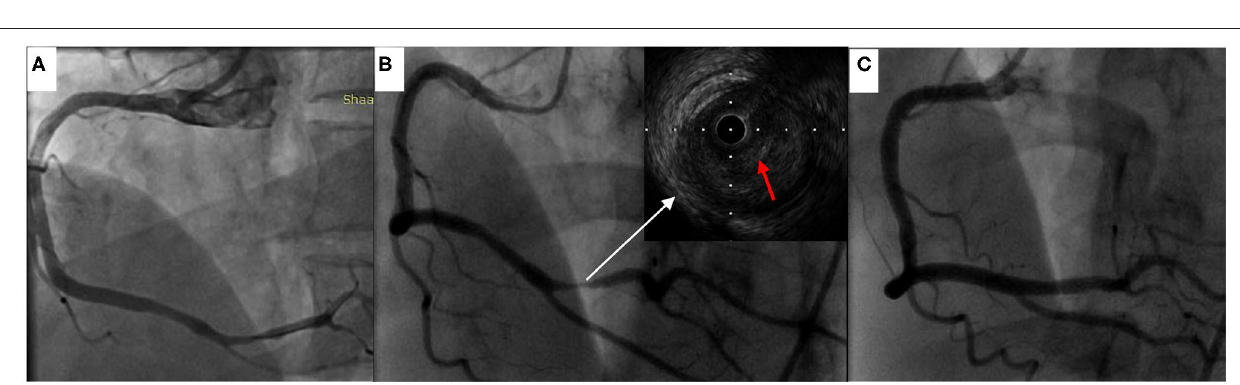
FIGURE 3 | Coronary angiography and intravascular ultrasound findings. (A) The right coronary angiography results 2 months earlier. (B) Coronary angiography revealed severe stenosis in the distal right coronary artery, and intravascular ultrasound demonstrated plaque rupture and thrombosis (red arrow indicated thrombosis). (C) Coronary angiography after stent implantation showed good